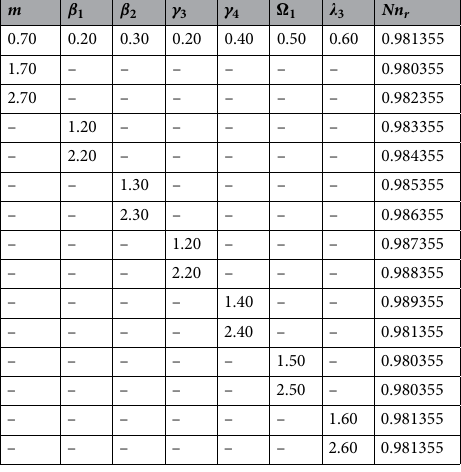
Table 5. Numerical values of motile density